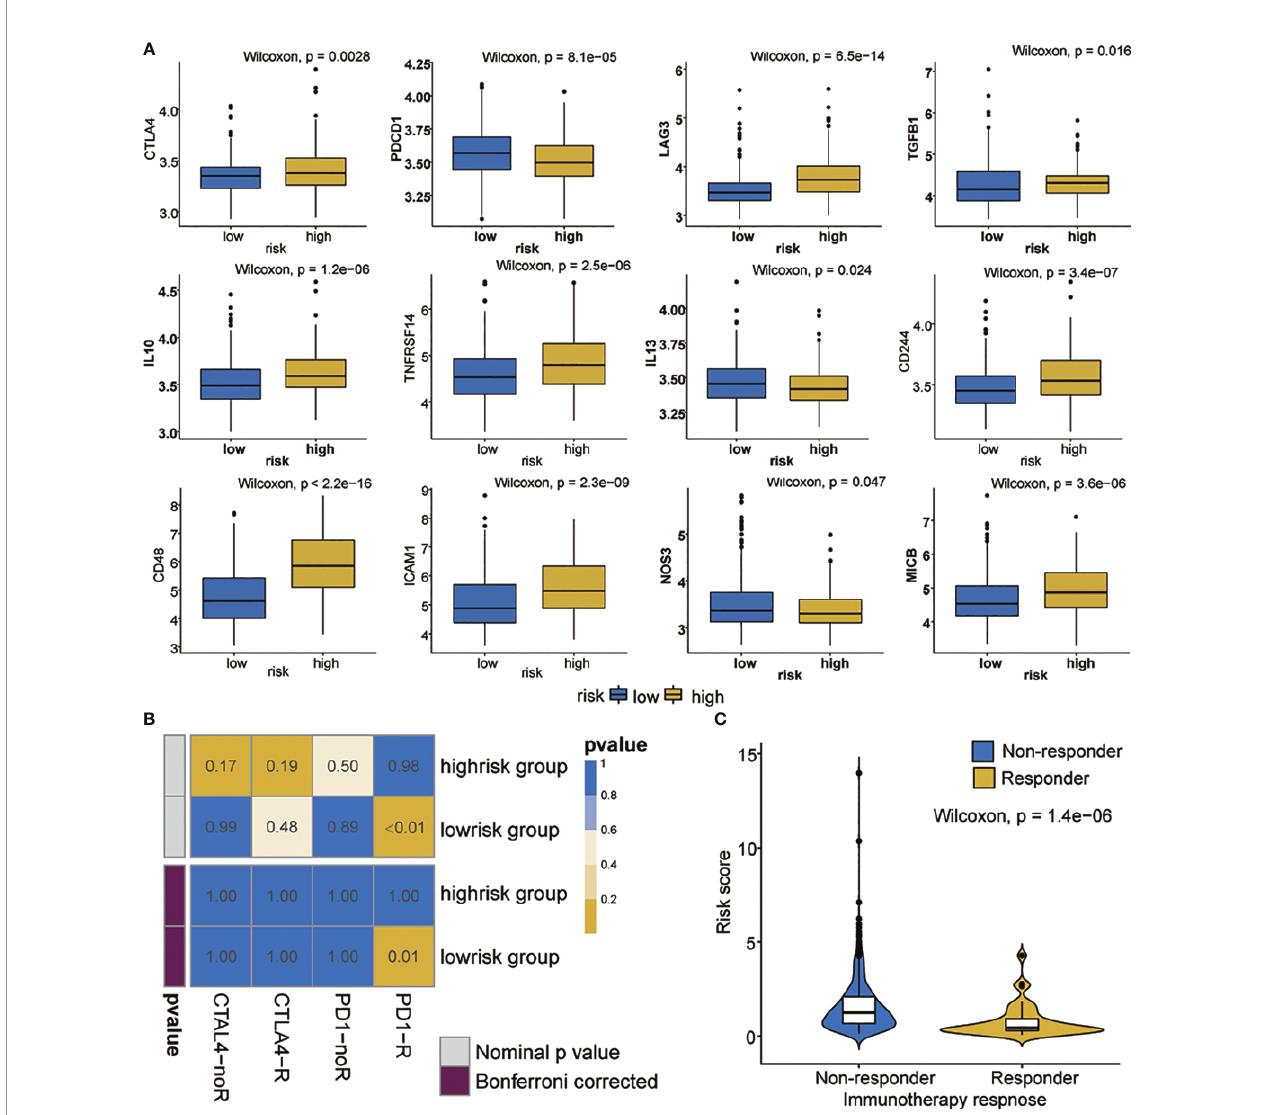
FIGURE 6 | Immunotherapeuticresponses in high- andlow-risk groups with ovarian cancer. (A) Differential expression of 12 immune checkpoints. (B) Immunotherapeutic responses to anti-PD1and anti-CTLA4 treatments. (C) Correlation between riskscore and immunotherapy